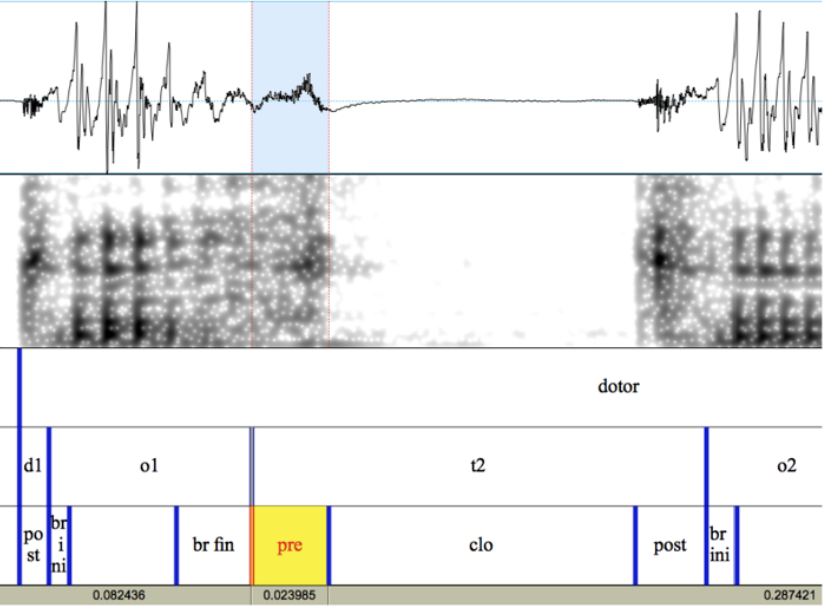
Figure 2: Pre-aspiration in the word dotor ‘inside’. ‘clo’ = closure, ‘post’ = release, ‘br ini’ = breathiness caused by preceding release, ‘br (cid:976)in’ = breathiness preceding voiceless pre-aspiration (or occurring without pre-aspiration at the end of the